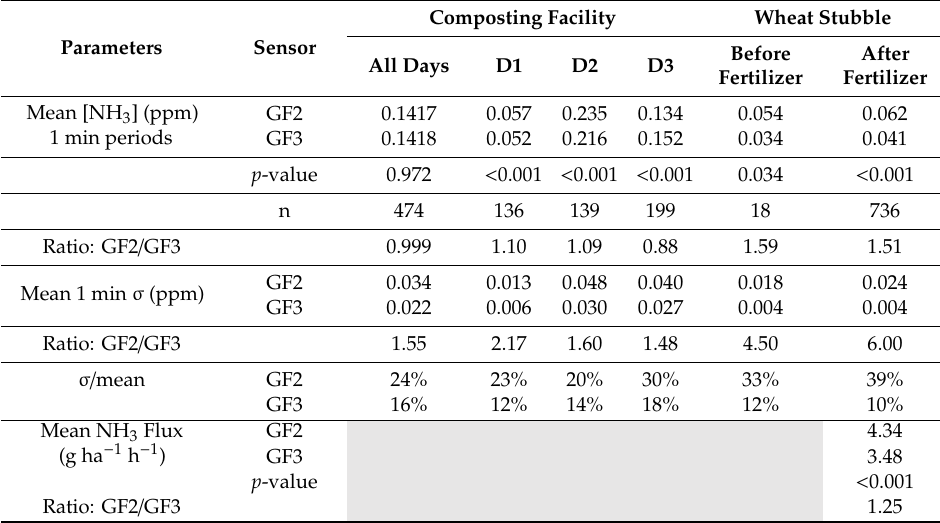
Table 2. Ratios of the means and standard deviations ( σ ) calculated on a 1 min basis of NH 3 concentrations over each measurement period. Averages are on daily basis (D1, D2 and D3) at the composter and before and after fertilizer application at the field trial. P-values from paired di ff erence tests are shown. Composting Facility Wheat Parameters Sensor